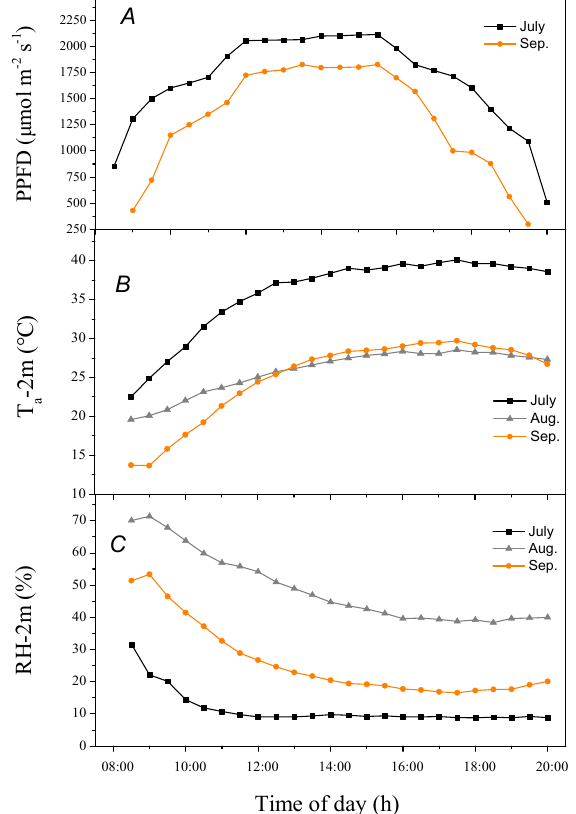
Figure 4. Diurnal changes in the photon flux density (PPFD) ( A ), air temperature (Ta) ( B ) and air relative humidity (RH) ( C ) for July, August and September in 2016.